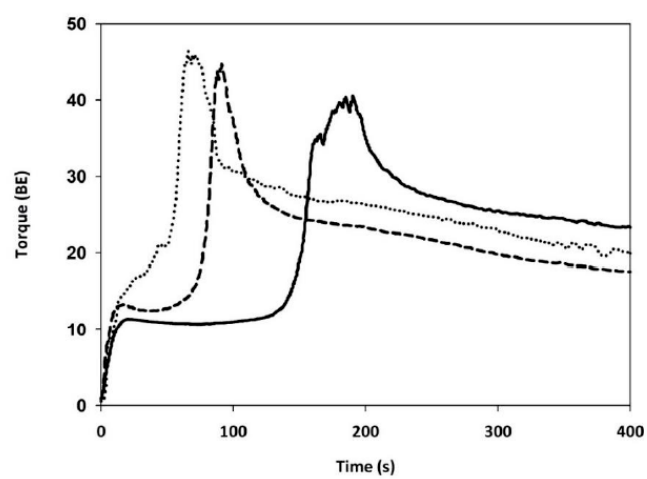
Figure 3. GlutoPeak profiles of refined wheat flour alone (solid line) and in presence of bran from un-sprouted wheat (dotted line) or bran from sprouted wheat (dash line). Table 2. Gluten aggregation and mixing properties of refined wheat flour alone, with bran from un-sprouted wheat, or bran from sprouted